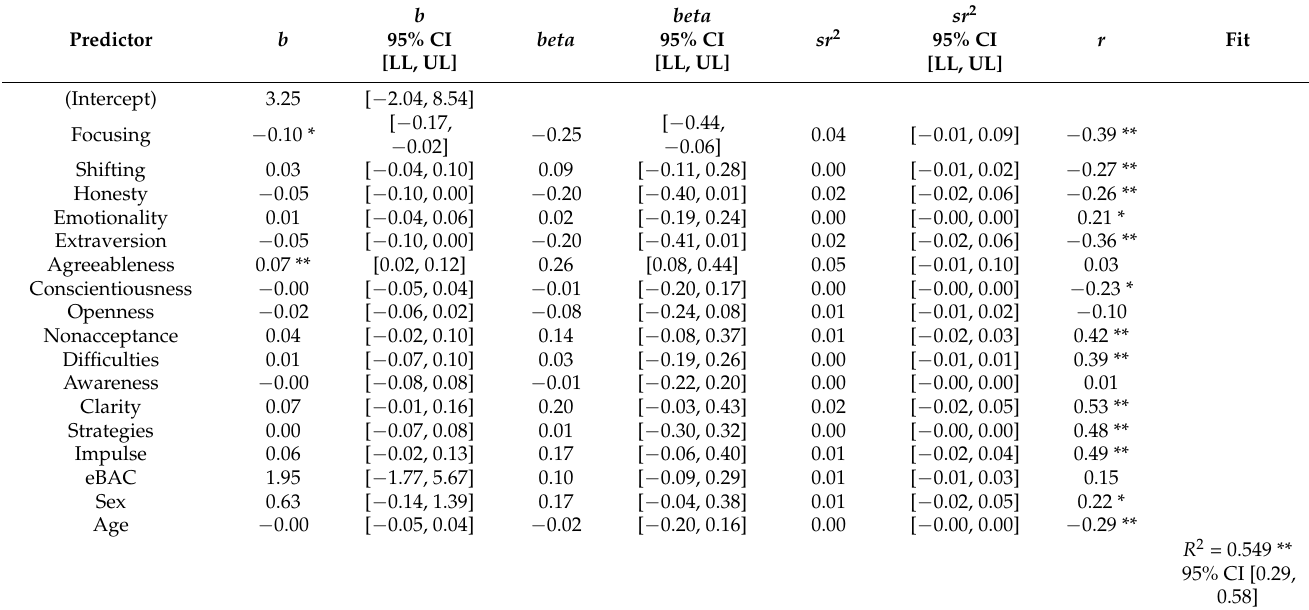
Table 1. Regression results using mean hangover severity scores as the